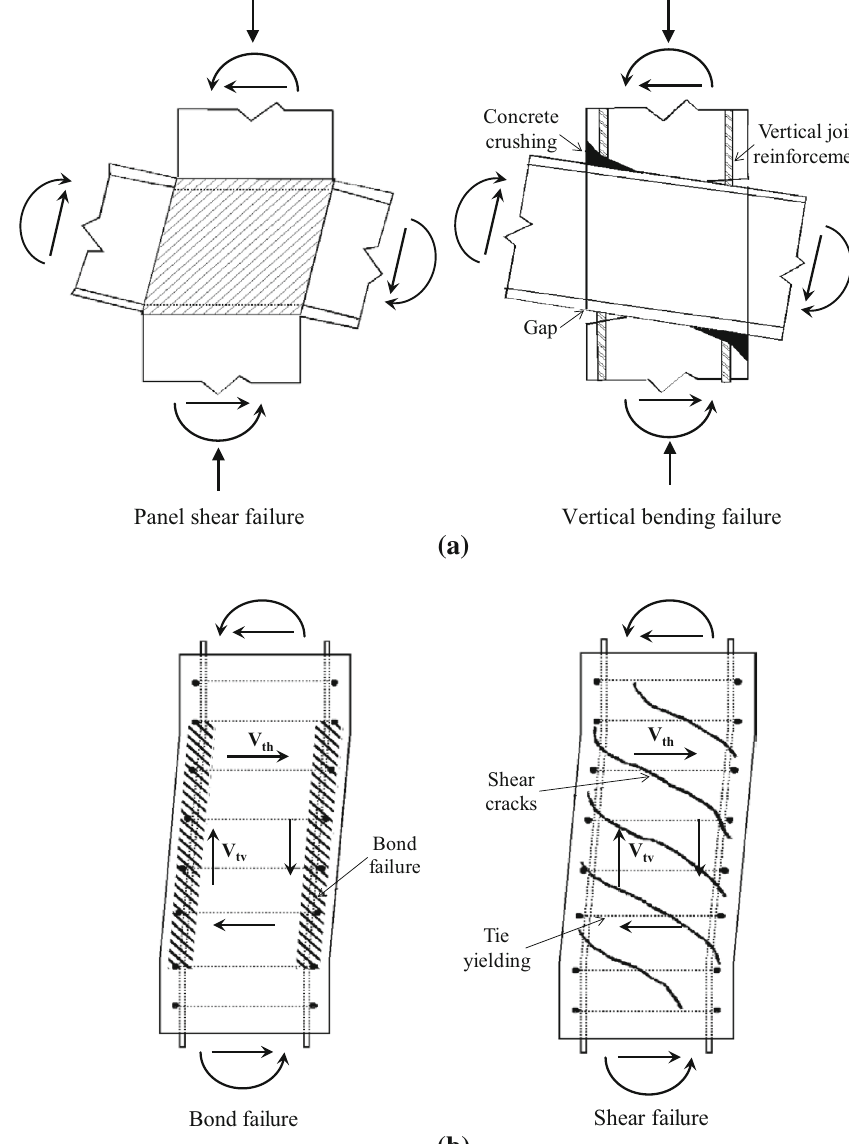
Fig. 1 Failure modes of connections in reinforced concrete and steel (RCS) composite systems: a internal and b external element